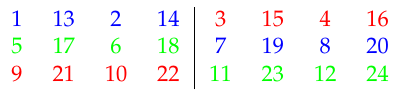
Table 2. Winding Distribution Table for a winding with N = 24, p = 2 and m = 3.